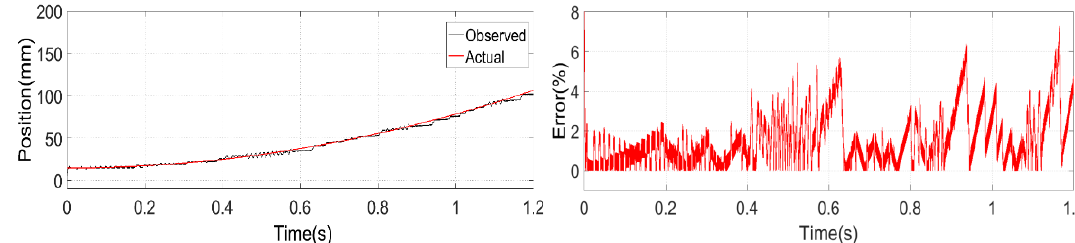
Electronics 2020 , 9 , x FOR PEER REVIEW Figure 10. Position observation result at zero and low speed. Figure 10. Position observation result at zero and low speed.